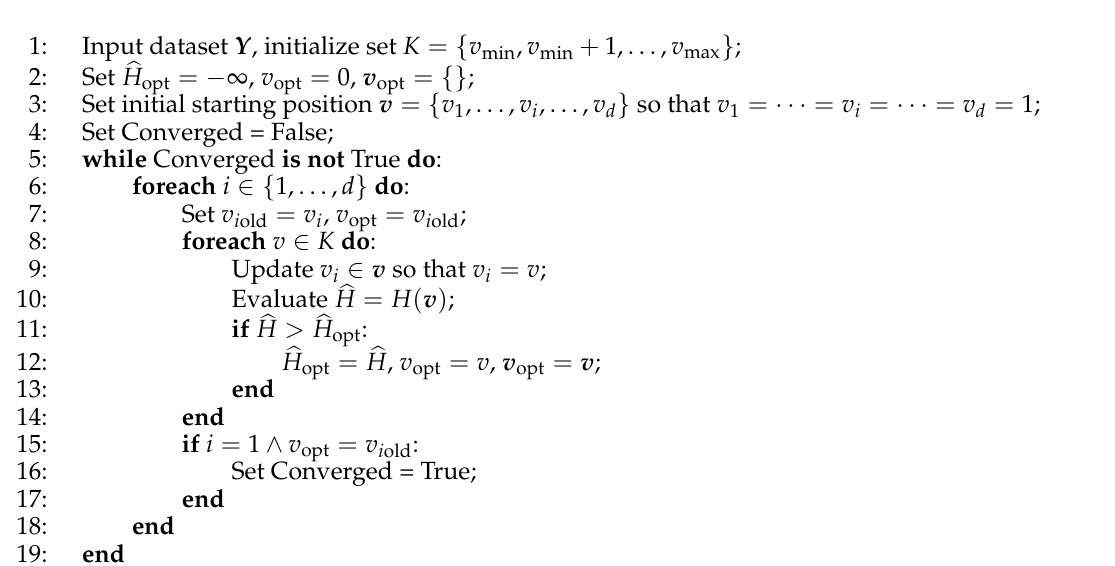
Algorithm 6: Coordinate-descent algorithm for optimum histogram binning v